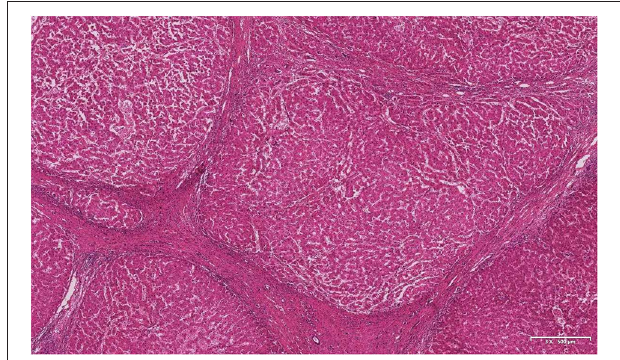
FIGURE 4 | Hepatectomy specimen